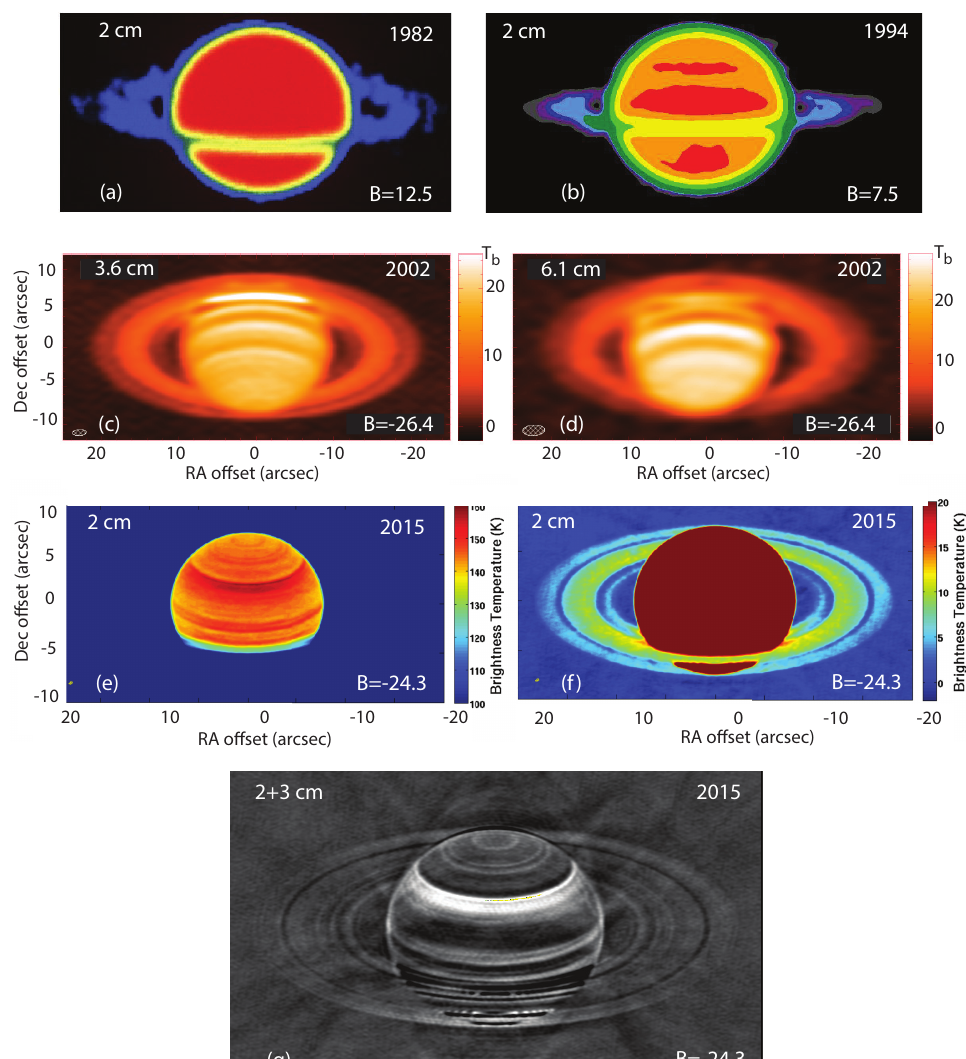
Figure 12. Several radio images of Saturn taken with the VLA between 1982 and 2015. ( a ) Historical VLA image at a wavelength of 2 cm, taken in 1982. The planet itself is seen in red, with the yellow outline caused by beam convolution. The much fainter rings show up in blue [114]. ( b ) A 2-cm map from 1994. Bright bands in the northern hemisphere are clearly visible [107]. ( c , d ) Saturn at 3.6 and 6.1 cm in 2002, after subtraction of all but 20 K from the average brightness of the disk. Brightness temperature differences in Kelvin are indicated. The half power beam width (HPBW) is indicated in the lower left corner [113]. ( e , f ) Saturn at 2 cm in May 2015, after the VLA upgrade. The color range for the panels is chosen to bring out the structure on the planet ( e ) and of the rings ( g ). The tiny yellow ellipses in the lower left indicate the HPBW of the beam [109]. ( g ) Map from May 2015 after combining the 2 and 3.5 cm data, and subtracting a uniform wavelength-dependent limb-darkened model of the disk and [109]’s best-fit model of Saturn’s rings. (Courtesy: R. J. Sault and I. de